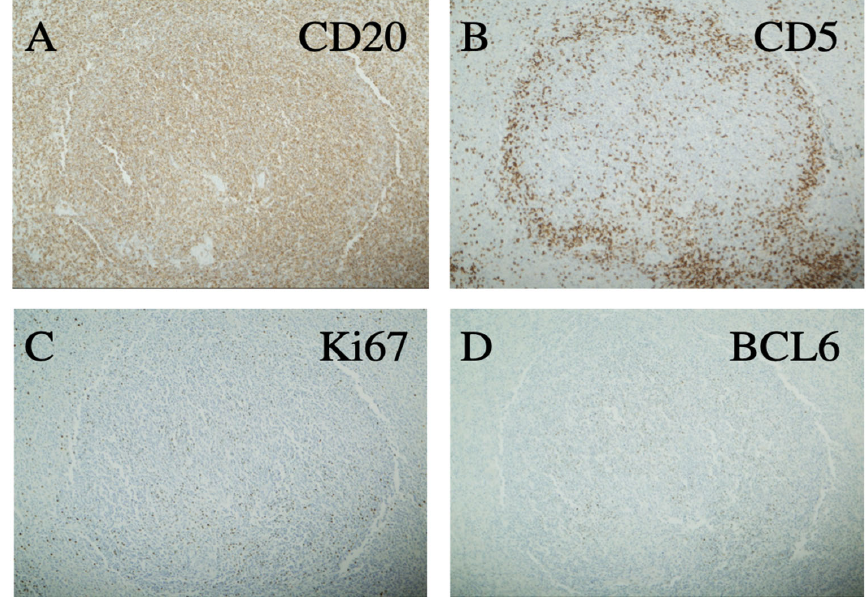
Figure 2. Immunohistochemistry of a representative splenic lymphoma nodule showing positivity for CD20 ( A ) and negativity for CD5 ( B ). Ki67 is focally increased above the usual level of low ‐ grade B ‐ cell lymphoma ( C ) and BCL6 is positive in a few larger cells without sheeting ( D ) All 100×. In December of 2011, a repeat BM biopsy showed increased lymphomatous burden (~50% of cellularity) without evidence of transformation. Karyotype analysis detected a new del (2) (q13q33) in addition to the complex karyotype previously observed: 45, XY, t (1; 17) (q25; q21), del (2) (q13q33), add (4) (p14), del(5) (q13q15) [4] (Table1).